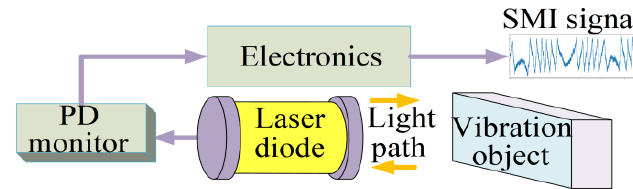
Figure 1. Circuit for forming SMI.